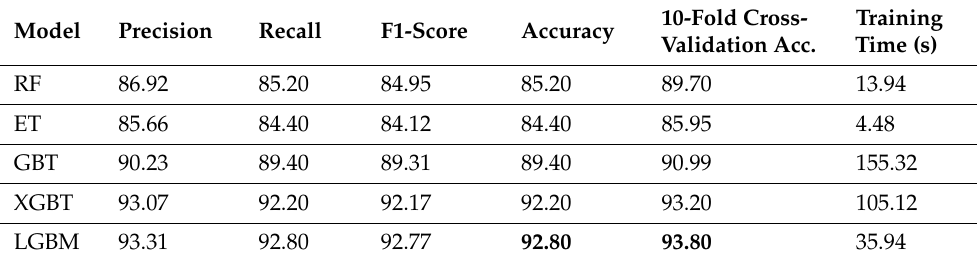
Table 5. Results on the test set with 40 packets as